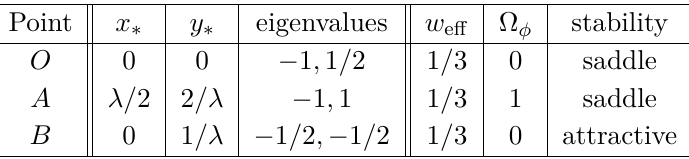
Table 1 . Fixed points of the system (3.9) that are not at